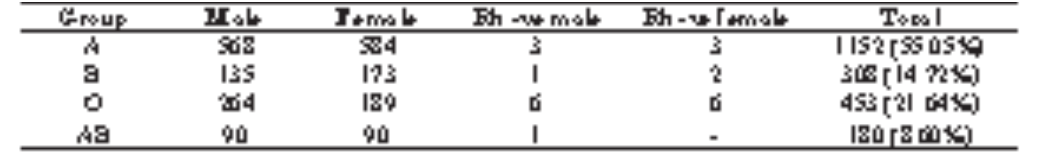
Table IV : Blood group distribution among the Jirels (Males = 1057, Females